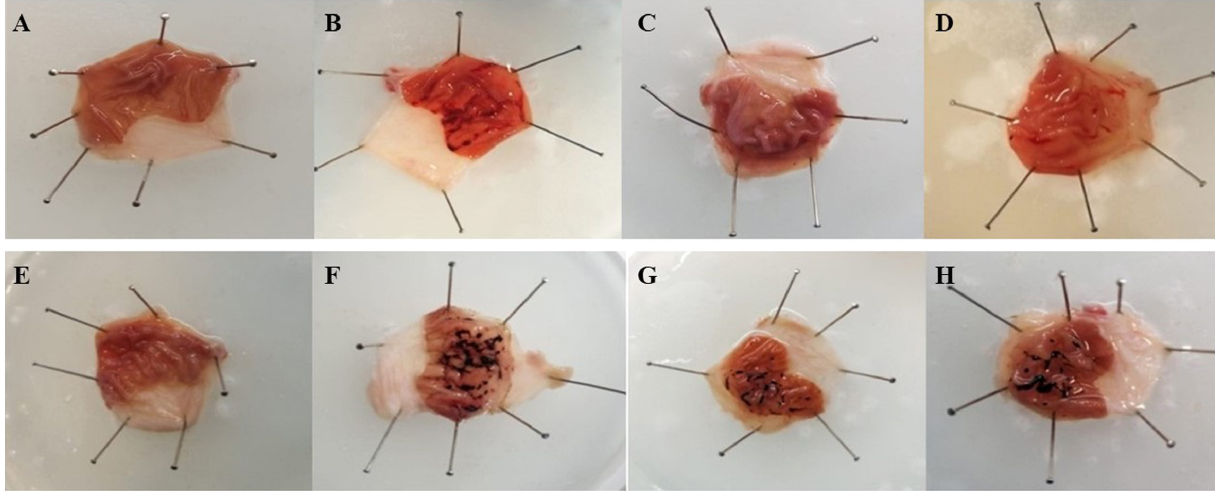
Figure 1. Representative photographs illustrating the gross macroscopic appearances of gastric samples from the experimental groups. Ethanol control (A), ethanol ulcer (B), metformin-treated ethanol ulcer (C), ranitidine-treated ethanol ulcer (D), indomethacin control (E), indomethacin ulcer (F), metformin-treated indomethacin ulcer (G), and ranitidine-treated indomethacin ulcer (H)